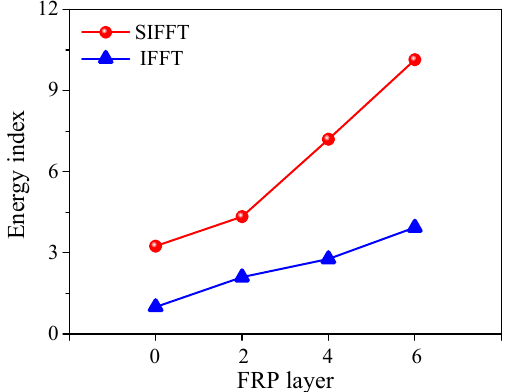
Figure 14. Energy index of confined plain ice and sawdust-reinforced ice.